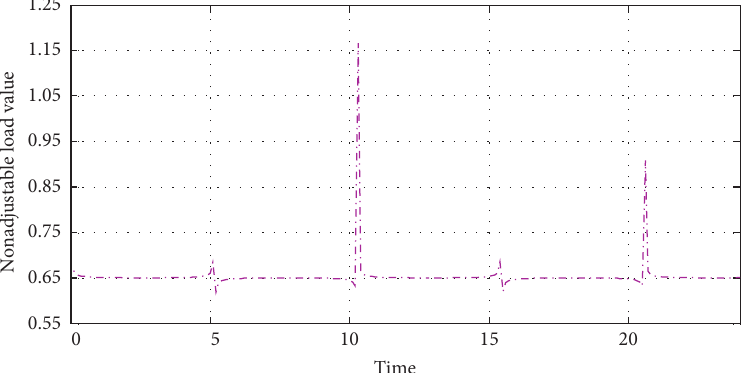
Figure 5: Nonadjustable load value.